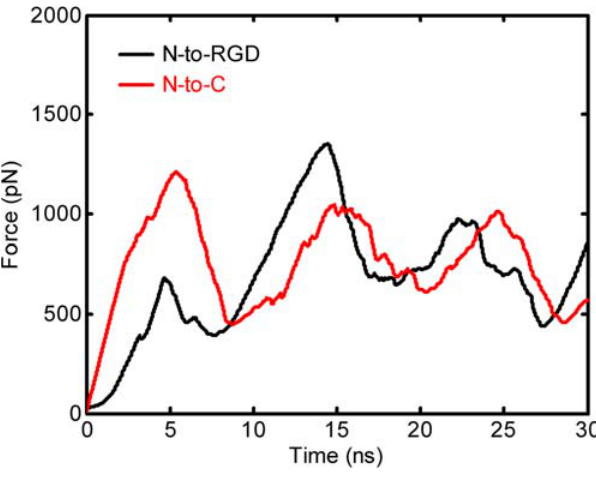
Figure 2. Extension Force Associated with Unfolding 10FNIII Along Either Axis. Averaging across each of the ten simulations along the N-to-RGD (black) or N-to-C (red) axis shows that the general properties of the force profiles are similar.